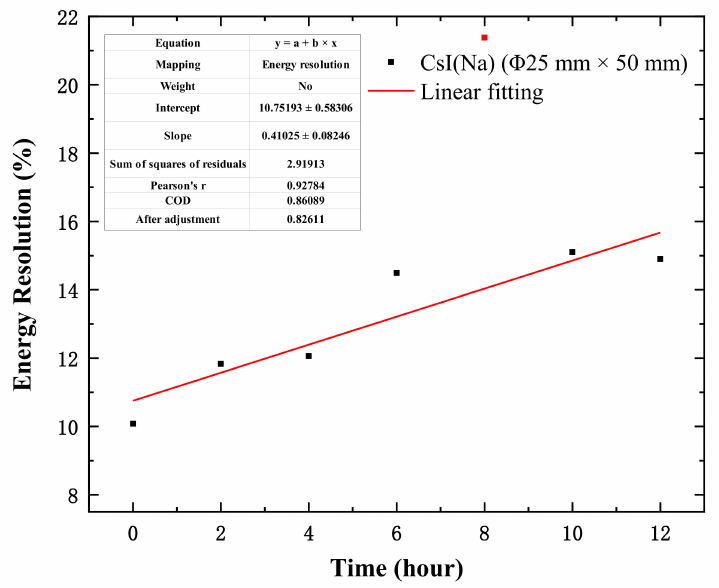
Figure 6. The energy resolution of the CsI(Na) crystal (size: Φ 25 mm × 50 mm) with different exposure times at 85% relative humidity under 137 Cs-662 keV γ ray